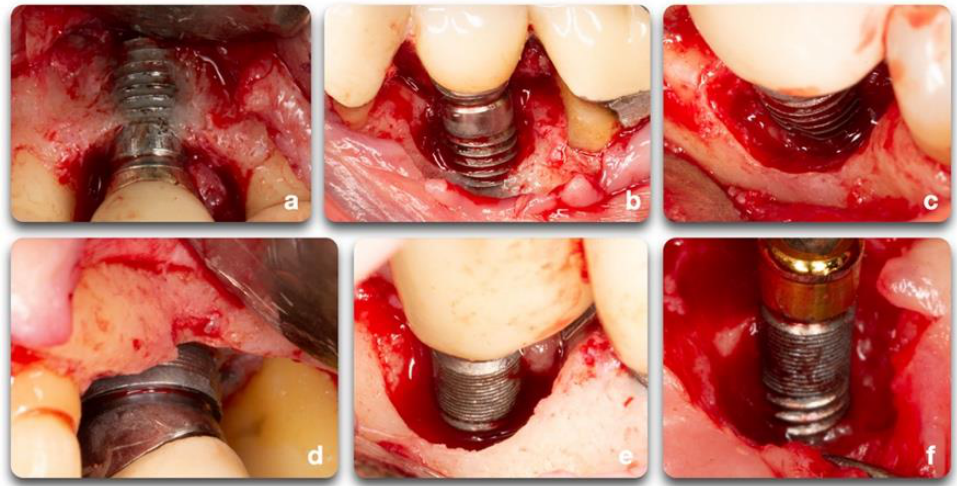
Figure 6. Clinical example of peri-implant bone defects; ( a ) facial dehiscence; ( b , c ) facial dehiscence and a semi-circumferential defect; ( d ) circumferential defect with a supra-crestal bone resorption; ( e ) circumferential defect; ( f ) semi-circumferential and supra-crestal bone defect.